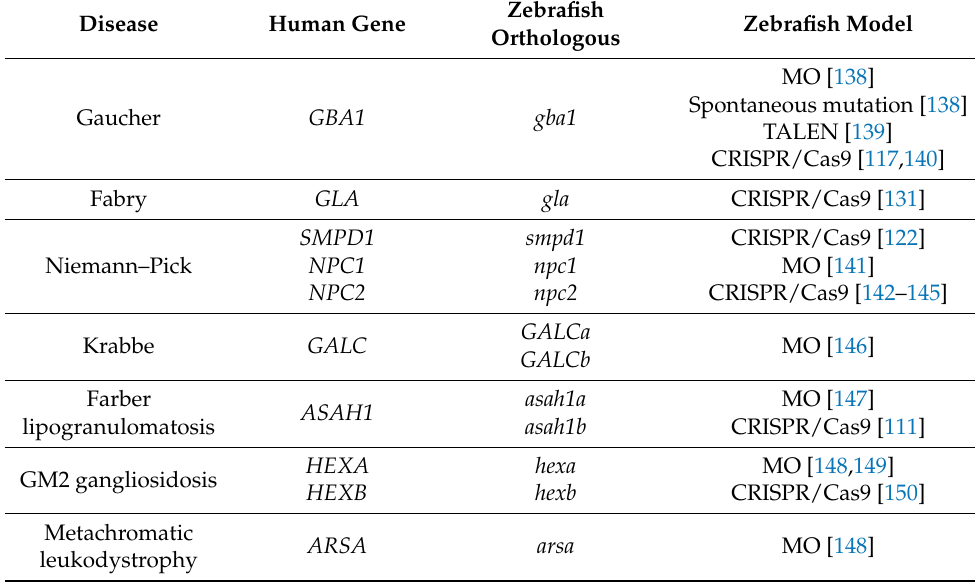
Table 2. Zebrafish models of